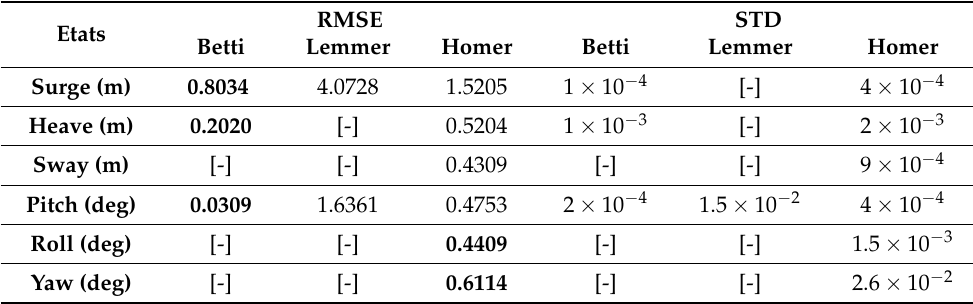
Table 2. Summary of simulation